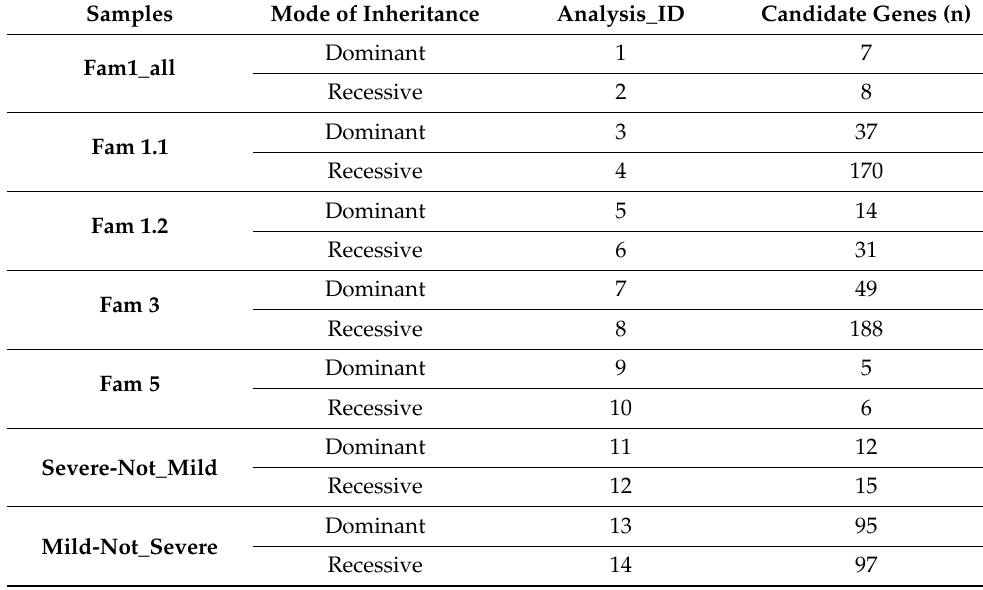
Table 2. Number of candidates modifying genes identified under different VAAST analysis categories. Severe-Not_Mild: analysis to identify variants present in severe patients but not in mild patients. Mild-Not_Severe: analysis to identify variants present in mild patients but not in severe patients.